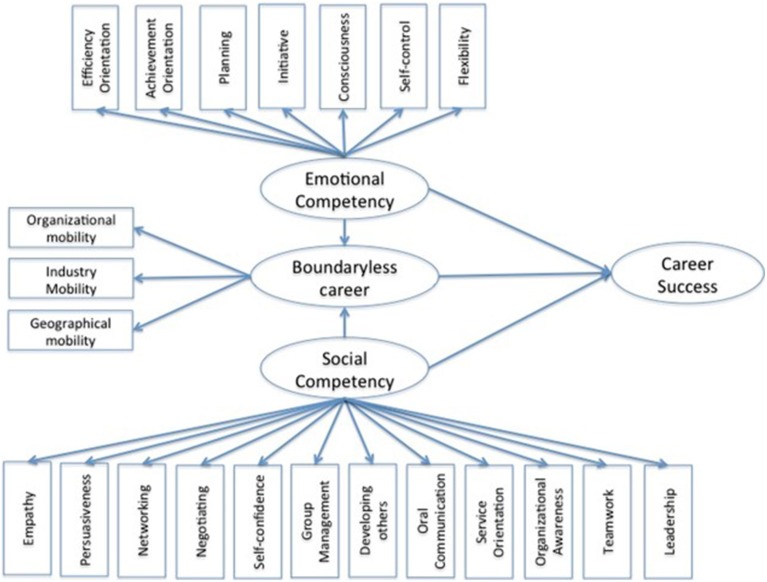
Conceptual model.